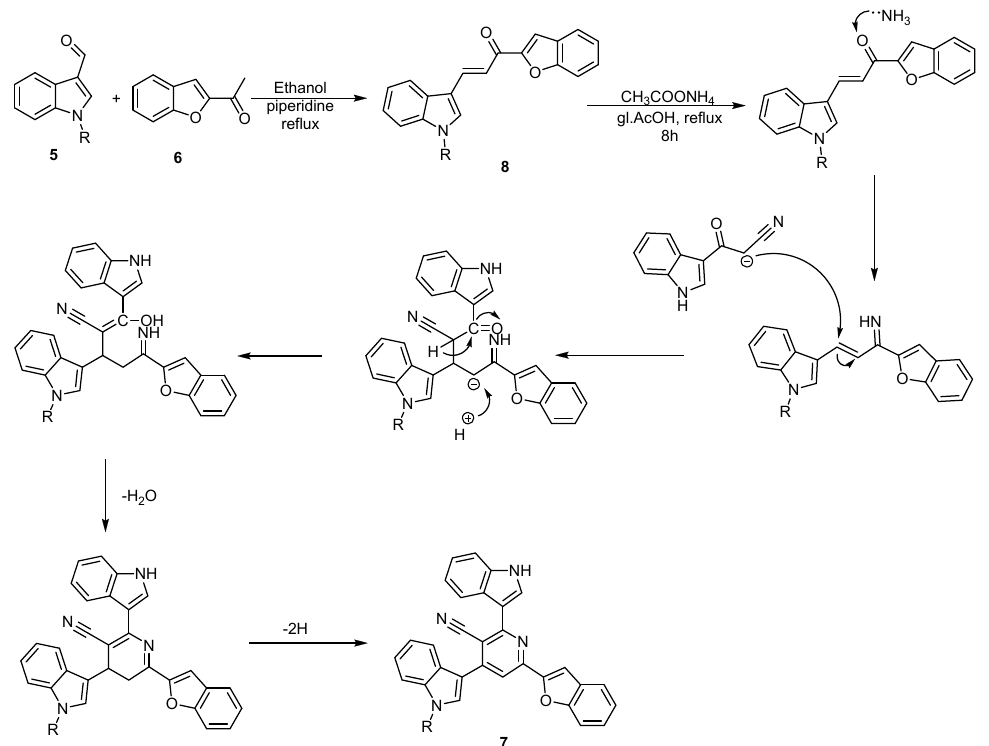
Scheme 3. Synthetic pathway of the α , β -unsaturated ketones 8 in the formation of 2,6-bis(1 H -indol-3-yl)-4-(benzofuran-2-